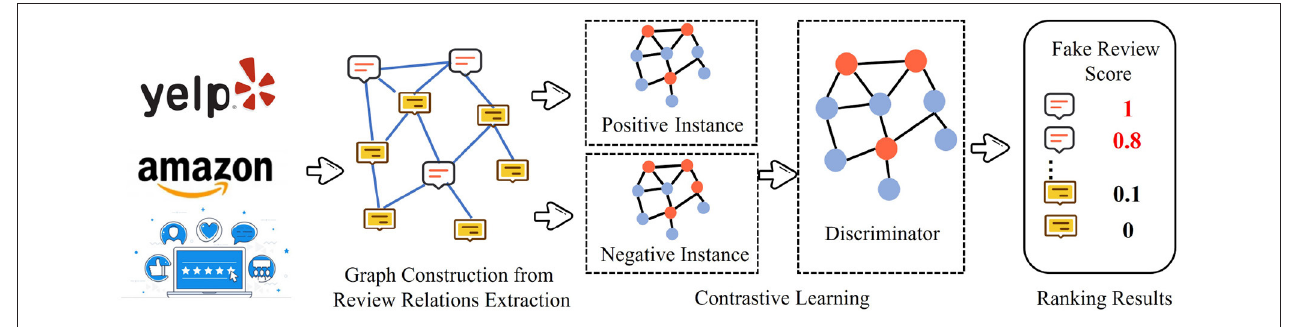
FIGURE 5 | Contrast-based methods for fake review